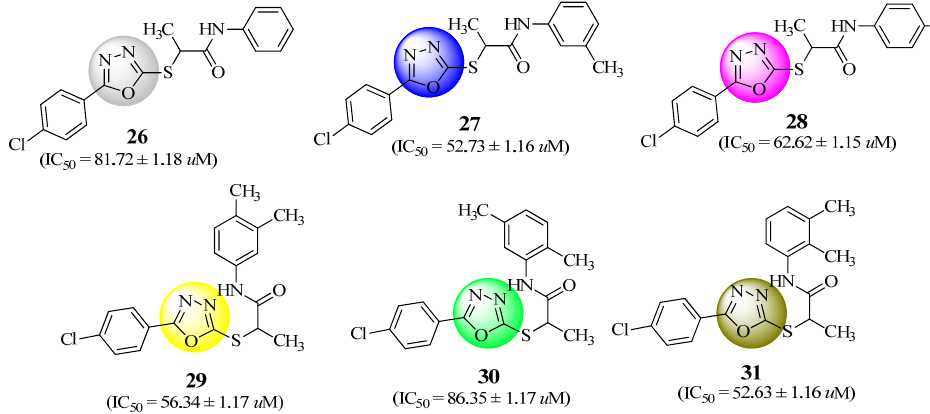
Figure 17. Oxadiazole derivatives with strong α -glycosidase inhibitory activity.